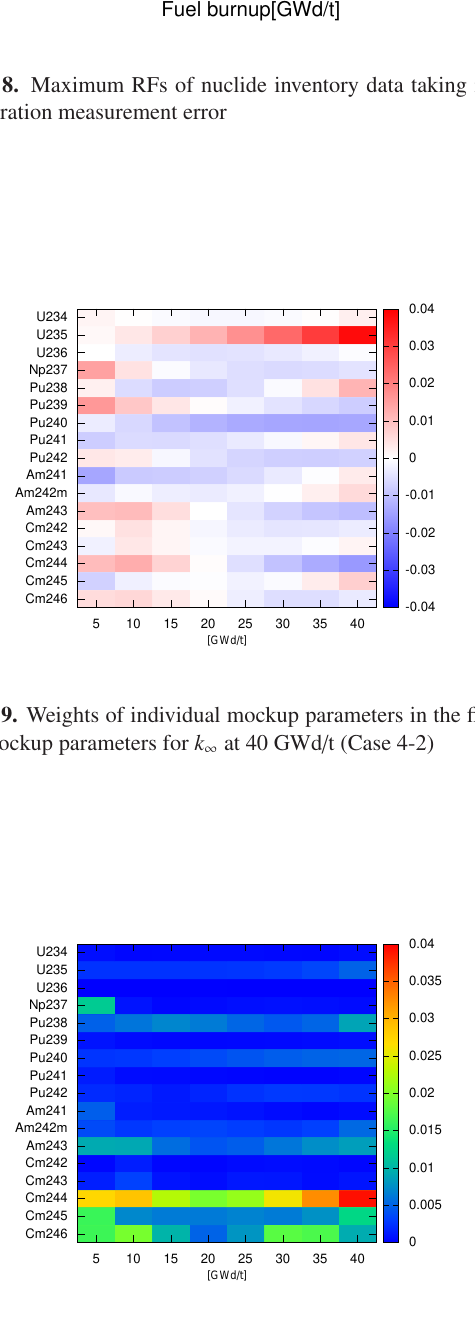
Figure 10. Reduction of the RFs when making individual weights zero (target: k at 40 GWd / t, Case 4-2) ∞